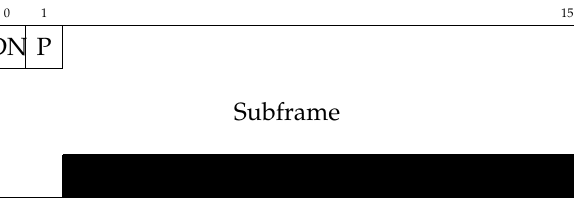
Figure 4. Hybrid network frame (HNF)